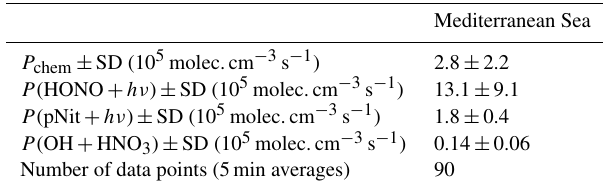
Table 3. Average required production rates to maintain the observed NO x mixing ratios in aged air masses during the Mediterranean Sea transit and contributions from processes